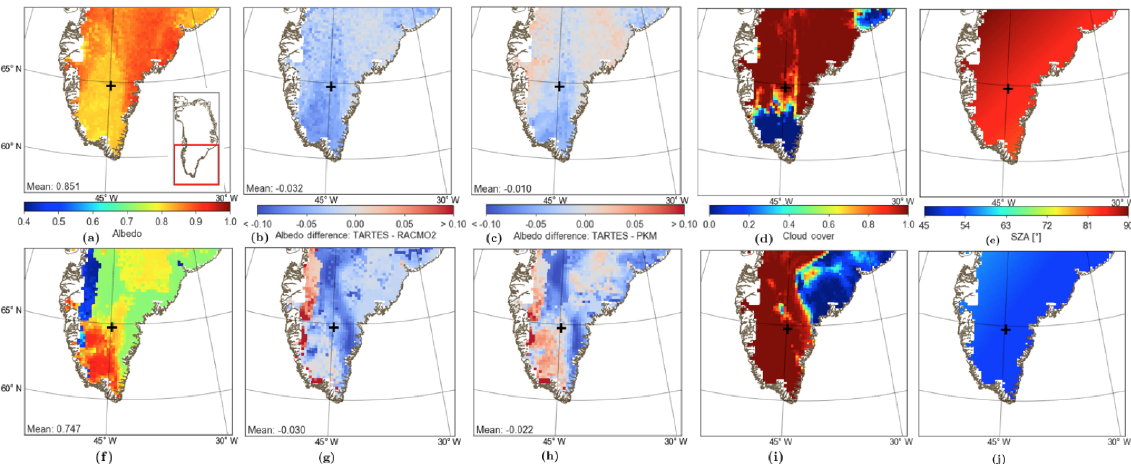
Figure 10. (a, f) Broadband albedo computed by TARTES using RACMO2 output for south Greenland during 15 February 2007, 12:00UTC (upper row, 09:00LT) and 15 July 2007, 12:00UTC (lower row, 09:00LT), ( b, g ) albedo difference between TARTES and RACMO2, (c, h) albedo difference between TARTES and PKM, (d, i) cloud cover, (e, j) and SZA. For panels (a–c) and (f–g) , the domain-averaged mean is indicated in the lower left corner. A plus symbol indicates the location of a time series analysis.